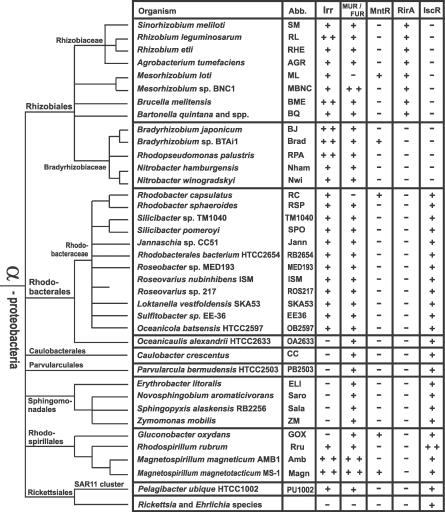
Distribution of Irr, Fur/Mur, MntR, RirA, and IscR Regulators in α-ProteobacteriaGenome abbreviations are given in the second column. The conventional taxonomic tree of α-proteobacteria shown on the left of the table was adapted from the NCBI Taxonomy Homepage (http://www.ncbi.nlm.nih.gov/Taxonomy/taxonomyhome.html) and is in agreement with the tree of α-proteobacteria based on 16S rRNA sequences [64]. Double plus (“++”) denotes the presence of two genes encoding copies of a given transcription factor.